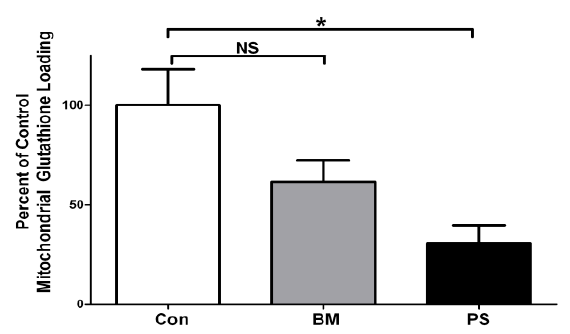
Figure 5. Mitochondria isolated from mouse lumbar spinal cord are dependent on OGC for GSH transport. Isolated mouse (NonTg) lumbar spinal cord mitochondria were incubated with 2 mM GSH in the presence of either vehicle (Con), 5 mM butylmalonate (BM), or 5 mM phenylsuccinate (PS) for 4 h. Samples were washed and total GSH was measured using a DTNB assay. Mean ± SEM; * p < 0.05 versus Con, NS = not significant, via a one ‐ way ANOVA with post hoc Tukey’s test; n = 4.